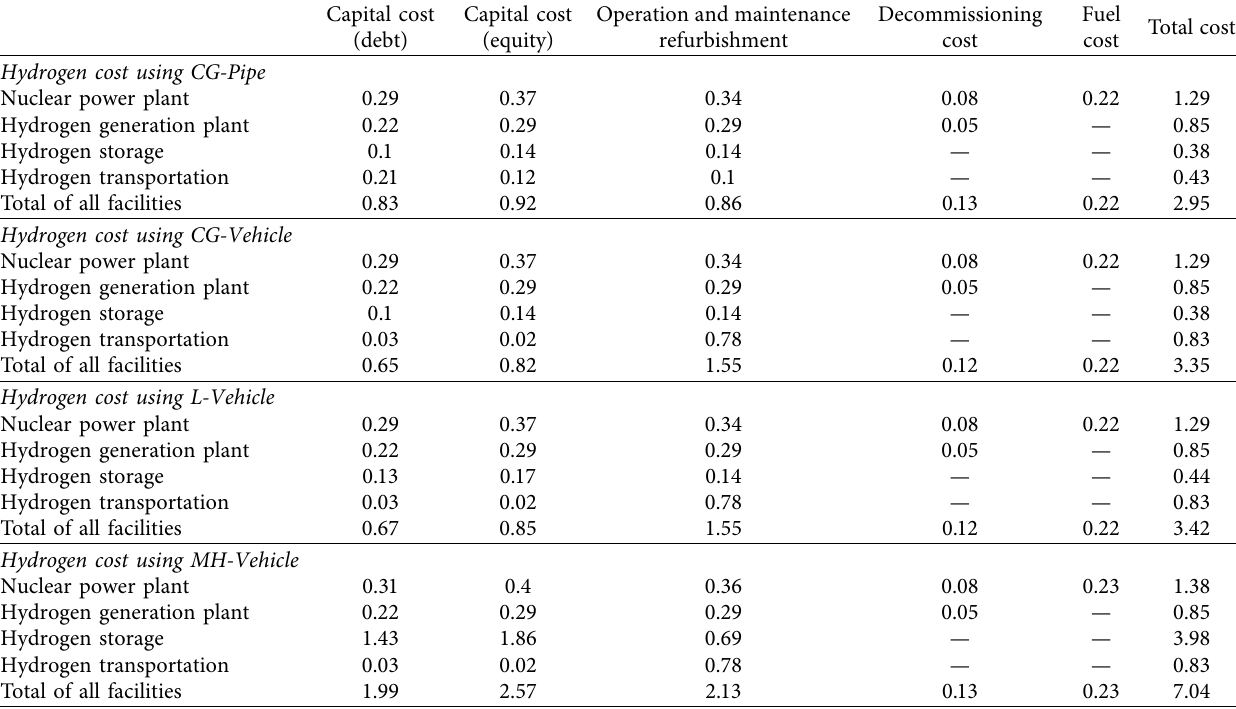
Table 4: Hydrogen production cost using NPM